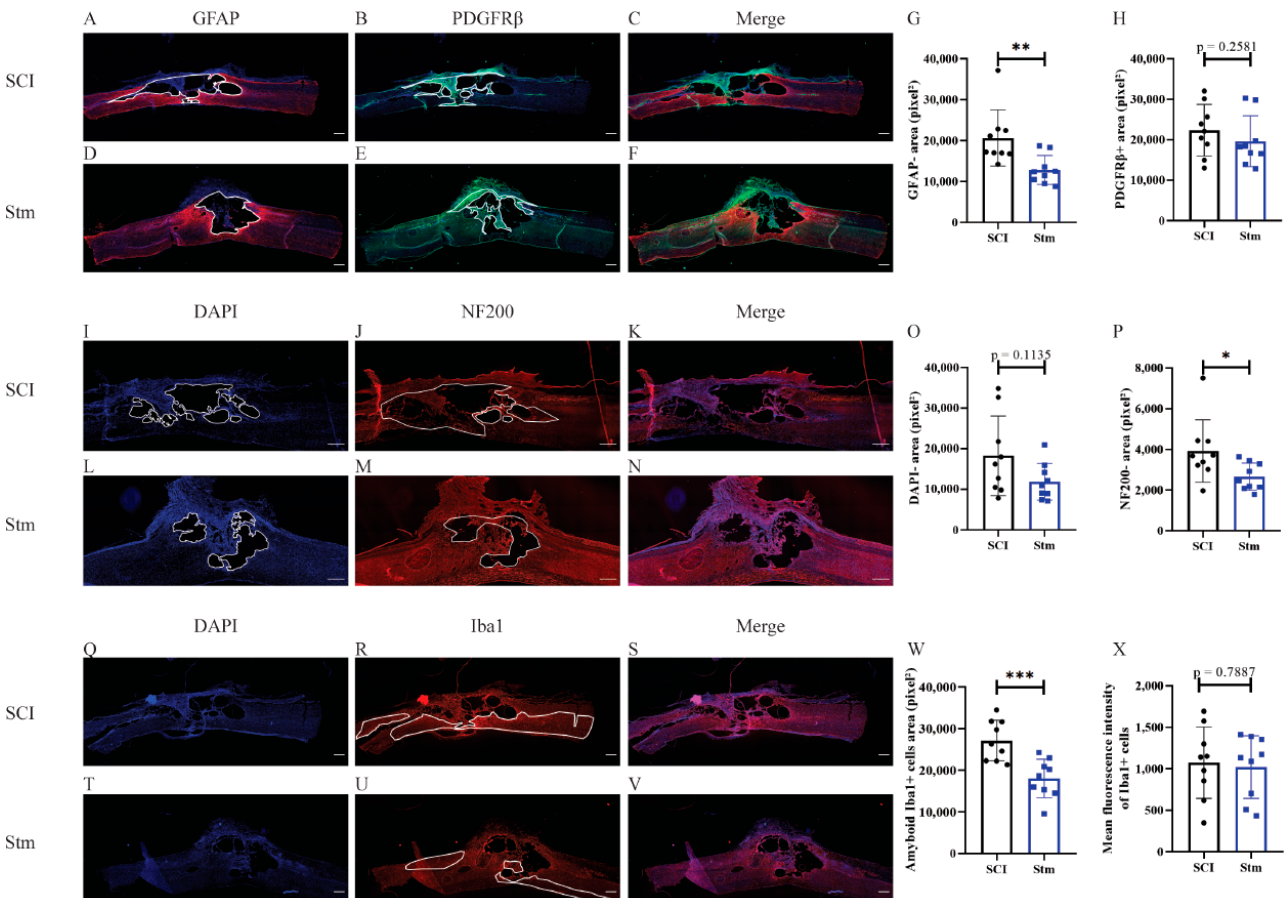
Figure 4. rTSMS treatment enhances tissue repair after a complete transection of the spinal cord 60 days after SCI in rats. At day 60, immunohistological analyses were performed. ( A – F , I – N , Q – T , U , V ) Representative pictures of sagittal spinal cord sections of ( A – C , I – K , Q – S ) SCI and ( D – F , L – N , T – V ) Stm (rTSMS treated) animals. Sections were stained with (A and D) GFAP, (B and E) PDGFR β , ( I , L , Q , T ) DAPI, ( J , M ) NF200 and ( R , U ) Iba1. ( G ) Quantification of astrocytic-negative area (GFAP-). ( H ) Quantification of fibrosis-positive area (PDGFR β +). ( O ) Quantification of DAPI-negative area (DAPI-). ( P ) Quantification of NF200-negative area (NF200-). (W) Quantification of Iba1 amyboid-positive cells’ area (Iba1+) and ( X ) quantification of Iba1+ mean fluorescence intensity. Scale bars are 200 μ m; n = 8 animals per group. Quantifications are expressed as average ± SD. Statistical evaluations are based on the Mann–Whitney test (* = p < 0.05, ** = p < 0.01 and *** = p < 0.001).